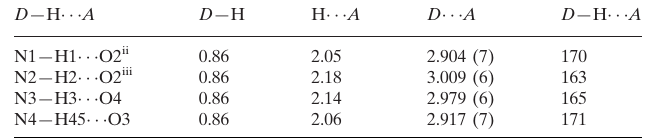
Hydrogen-bond geometry (A˚ , (cid:4)